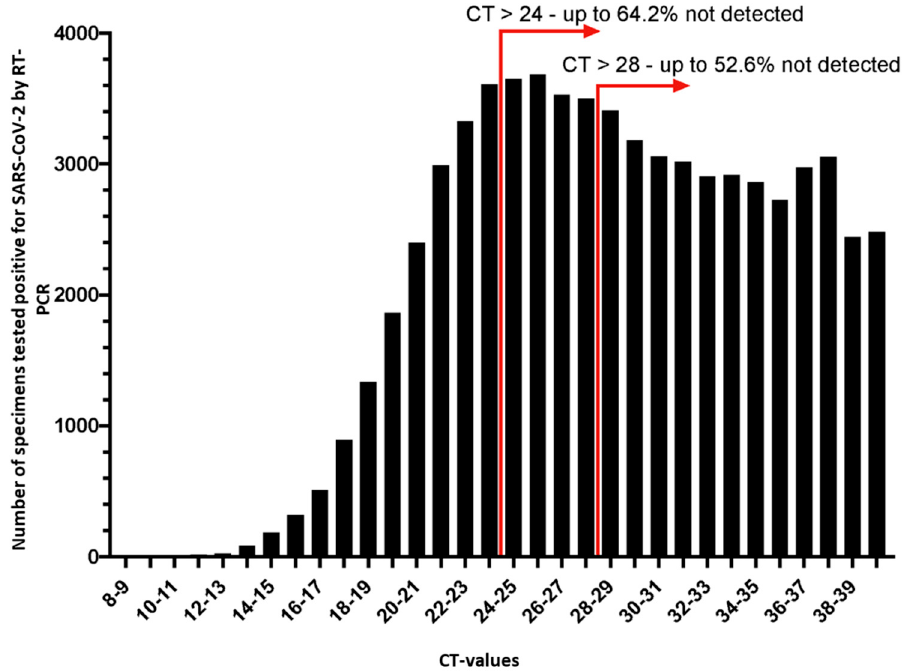
Figure 1. SARS-CoV-2-PCR Ct-value scattering of respiratory samples collected between 1 September and 23 December (2020).